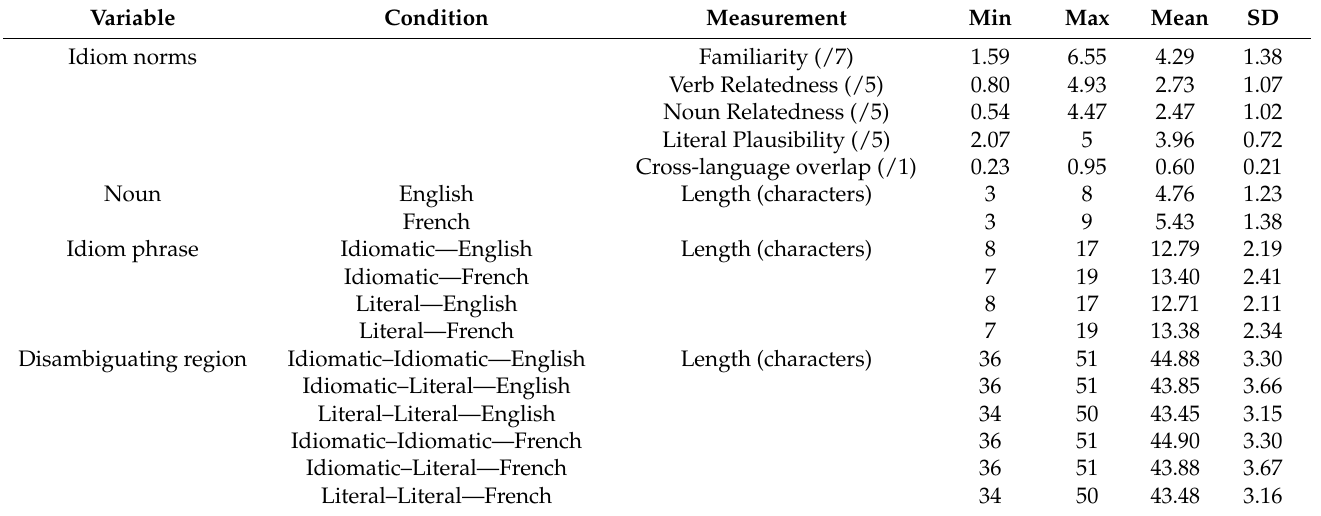
Table 7. Item and stimuli characteristics (Experiment